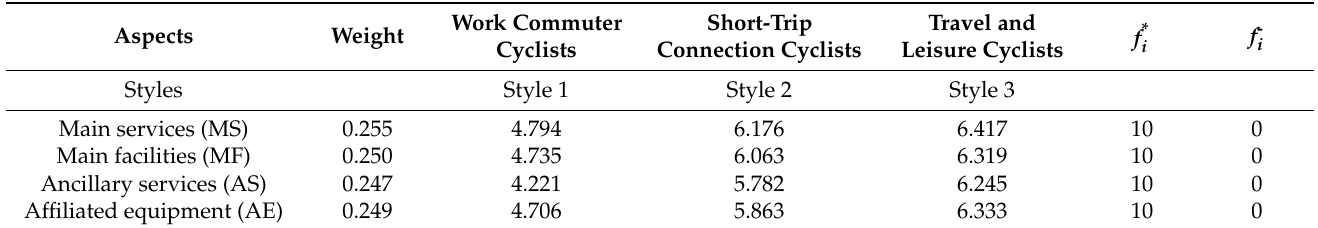
Table 16. The scores of f ik .